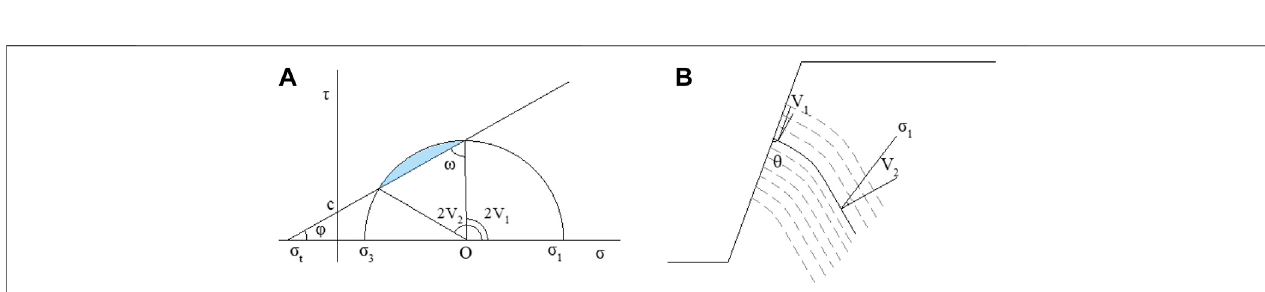
FIGURE 3 | Coulomb – Mohr diagram of the toppling condition of rock slab. (A) Coulomb – mohr diagram of toppling condition; (B) toppling form.